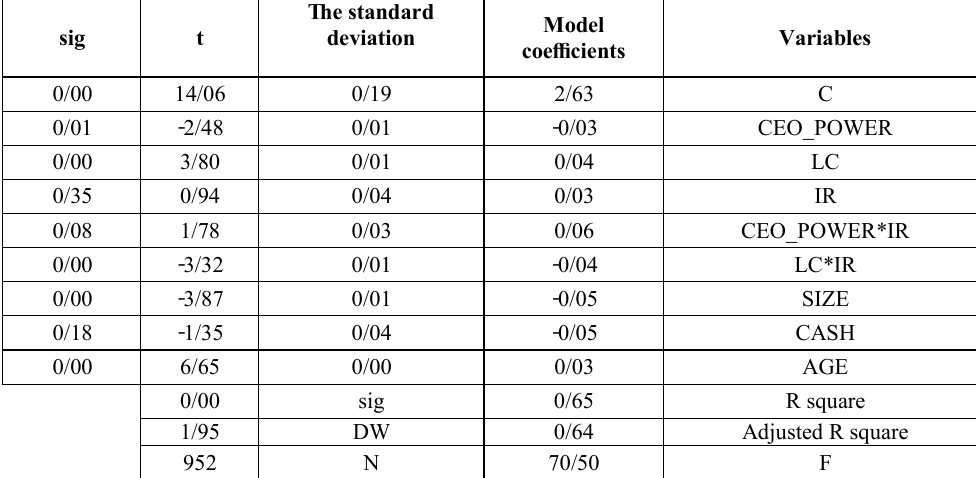
Table 5. Research model test